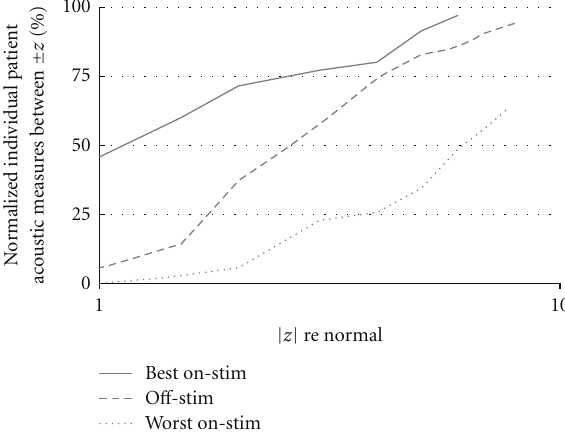
Figure 6: E ff ect of DBS on acoustic measures of speech: cumulative distribution of individual patient acoustic measures, normalized by scores of control subjects. For ease of visualization, the 0% and 100% extrema of the distributions are not